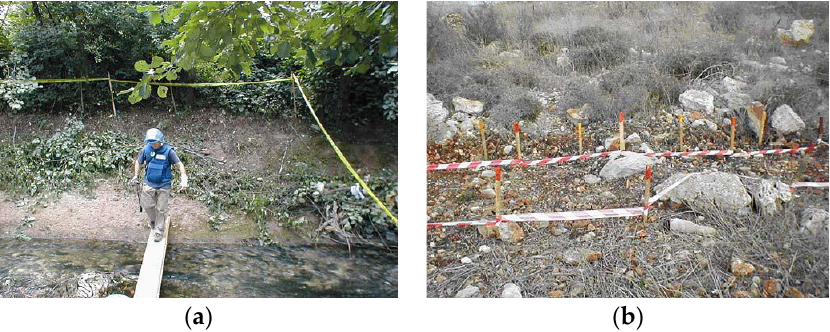
Figure 21. ( a ) Riverbank minefield in the Republic of Serbska and ( b ) minefield with a clearance lane in southern Lebanon.